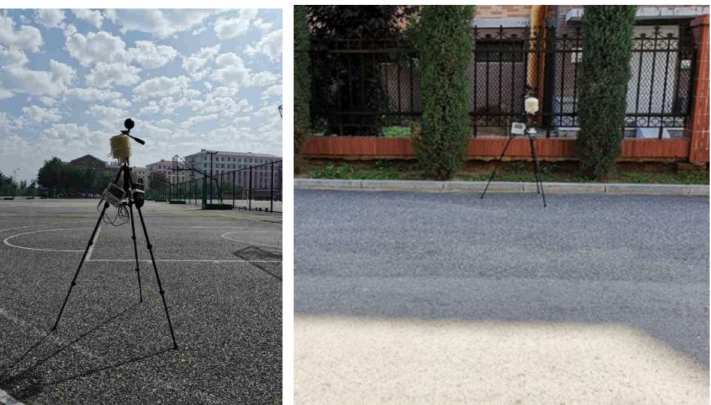
Figure 3. Measurement of thermal environment parameters under the sun ( left ) and under shade ( right